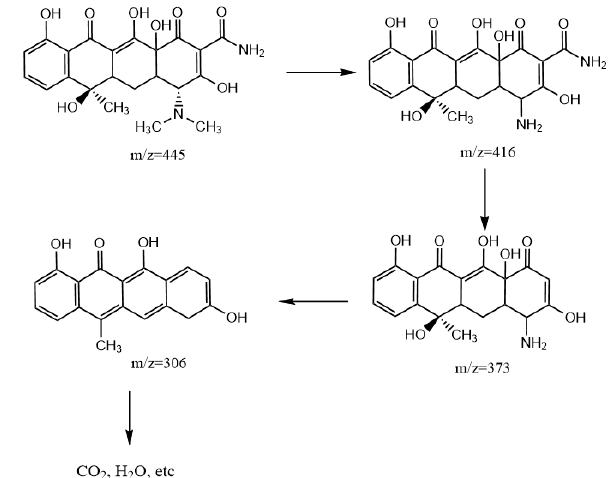
Figure 13. Possible pathways and intermediates of 0.4Ni/Ti-Bi 2 WO 6 photocatalytic degradation of tetracycline.